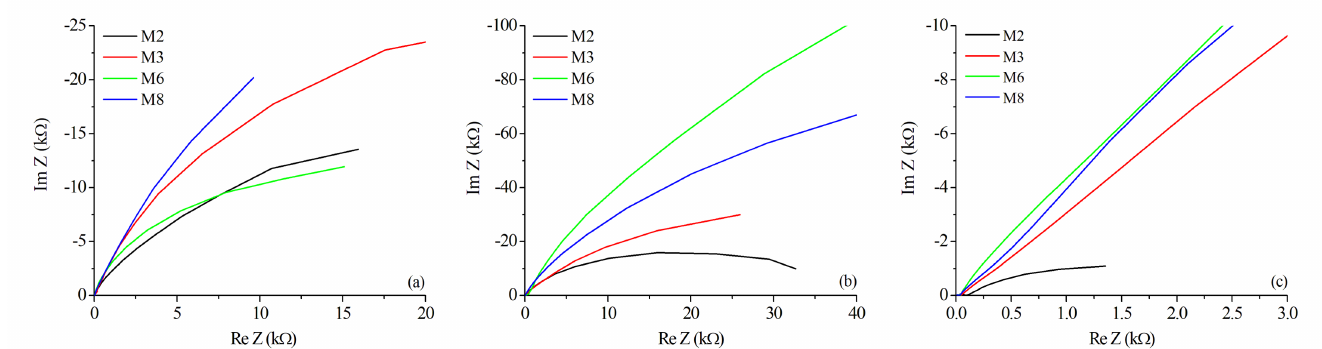
Figure 15. Nyquist diagrams for selected samples in different zones: ( a ) Base Metal, ( b ) Weld Zone, and ( c ) Heat-Affected